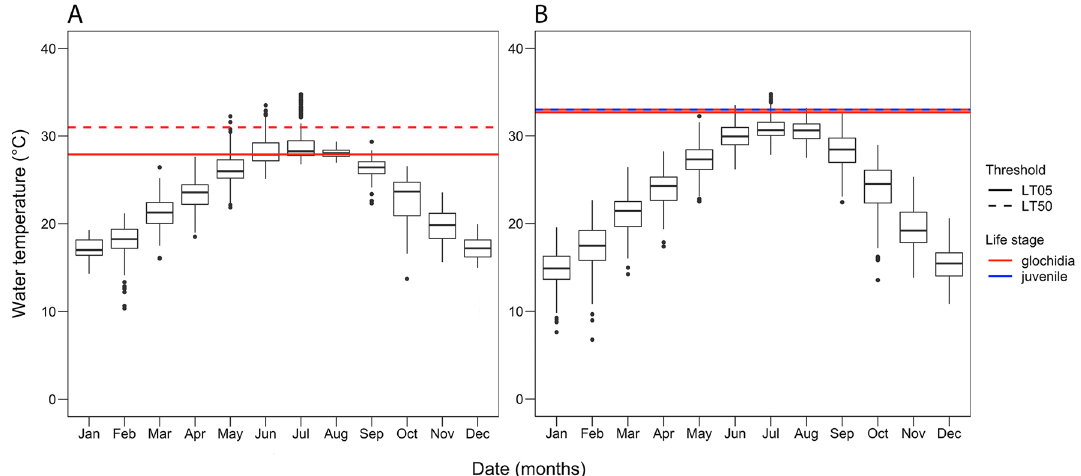
Figure 4. Water temperature and thermal tolerance data for two subpopulations of P. popeii in the Devils River. Red lines = glochidia, blue lines = juveniles, solid lines = LT05, and dashed lines = LT50. ( A ) Comparison of maximum daily water temperature at Grass Patch from March 2018 to August 2020 and laboratory derived thermal tolerance of Grass Patch P. popeii glochidia (24-h). ( B ) Comparison of maximum daily water temperature at Ruthies from October 2015 to August 2020 and laboratory derived thermal tolerance of Ruthies P. popeii for both glochidia (24-h) and juveniles